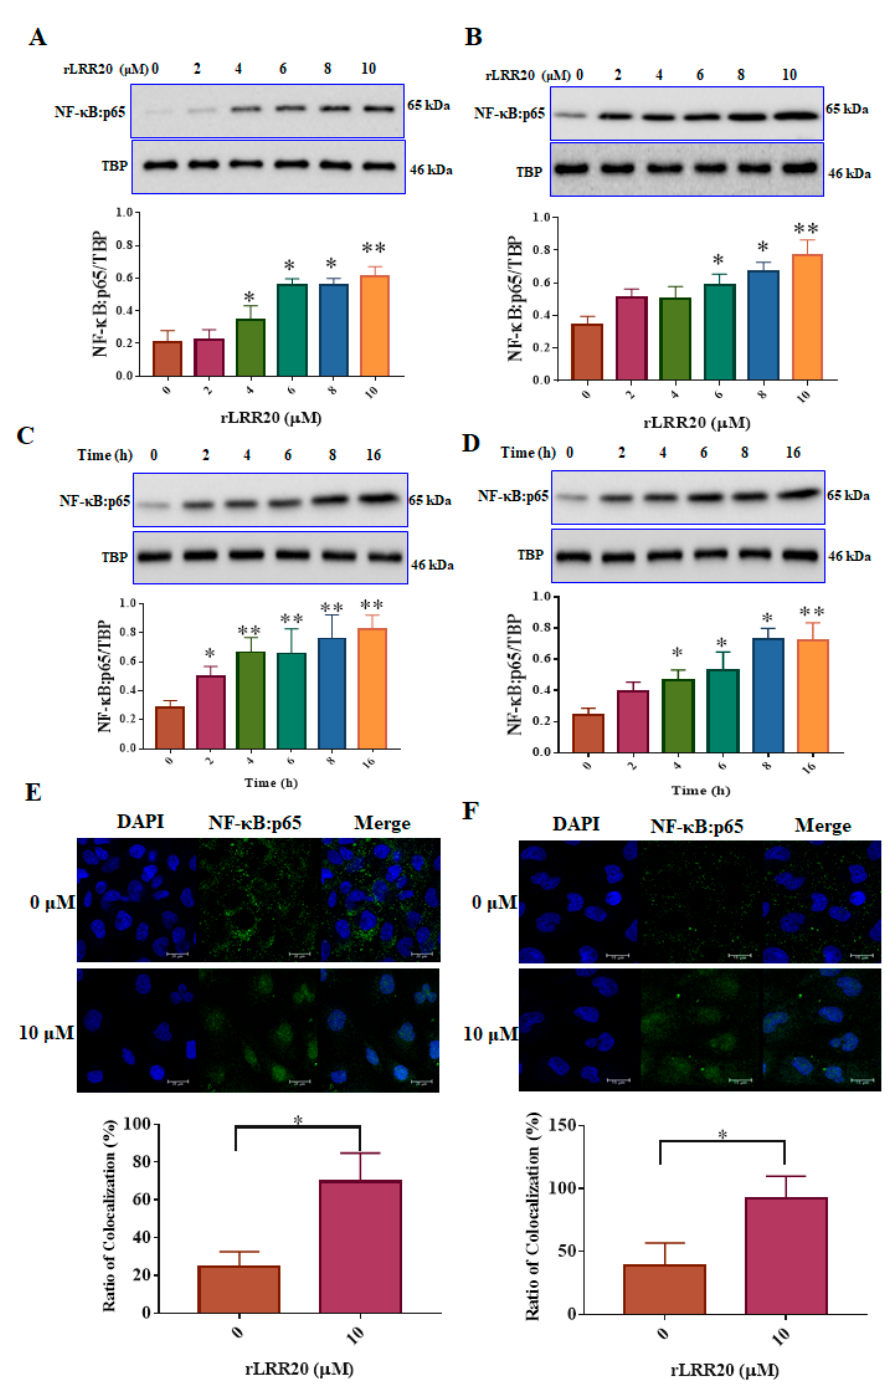
Figure 7. rLRR20 promotes the nuclear translocation of NF- κ B:p65. The nuclear fraction was prepared using a cytoplasmic and nuclear protein extraction kit (BRARZ106). NF- κ B:p65 was detected using the anti-p65 antibody. TATA-box binding protein (TBP) was used as the internal control. Effect of treatment with different concentrations of rLRR20 for 8 h on the levels of NF- κ B:p65 in the nucleus in HK2s ( A ) and hRPTECs ( B ). Effect of treatment with 10 µ M of rLRR20 for different durations on the NF- κ B:p65 levels in the nucleus in HK2s ( C ) and hRPTECs ( D ). ( E ) Effect of treatment with 10 µ M rLRR20 protein and phosphate-buffered saline for 8 h on the NF- κ B:p65 levels in HK2s ( E ) and hRPTECs ( F ) was examined using confocal microscopy. Mander’s overlap coefficients were calculated to determine the colocalization of NF- κ B:p65 with the nucleus. NF- κ B:p65 (green); nucleus (blue). ** p < 0.01; * p < 0.05.